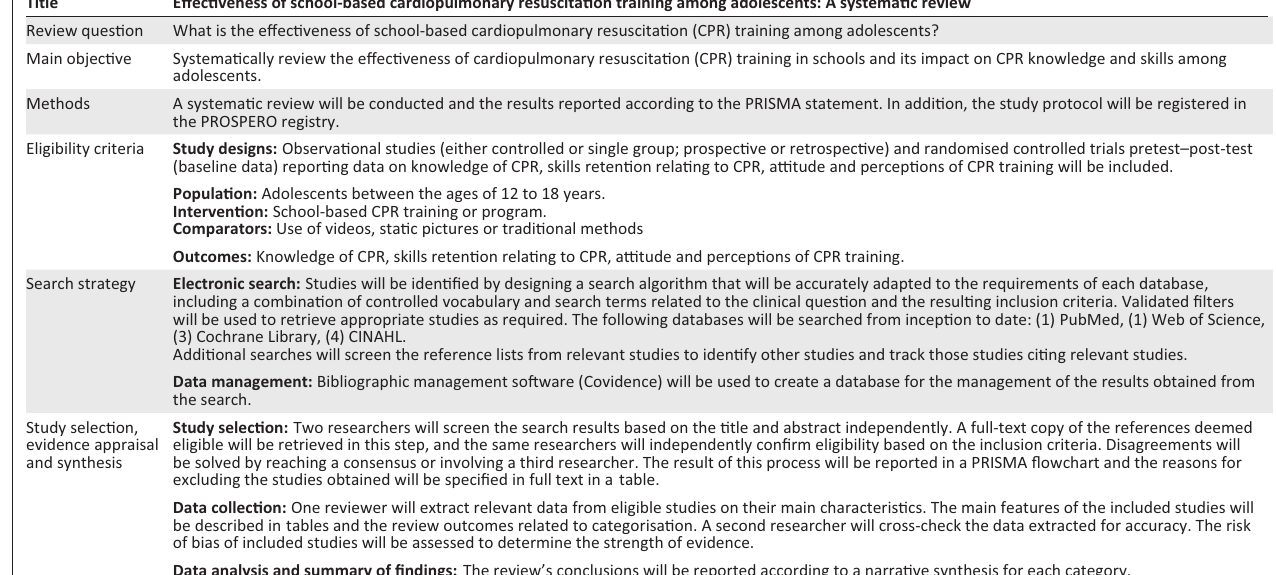
FIGURE 1-A1: Summary of review